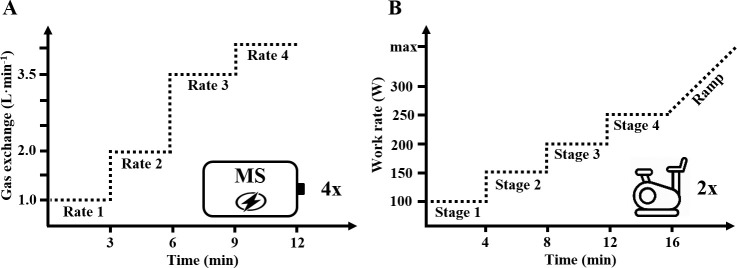
Test protocols for simulated (A, study 1) and biological (B, study 2) testing. To evaluate intra- and inter-unit reliability, study 1 consisted of four metabolic rates produced by a metabolic simulator (MS), conducted four times for breath-by-breath and four times for dynamic mixing chamber mode (left part A). To evaluate inter-unit differences, study 2 consisted of four increasing stages with a consecutive ramp test in 12 male athletes (right part B). The test was conducted twice with both units operating in a randomized order between participants either both in breath-by-breath or both in dynamic mixing chamber mode.